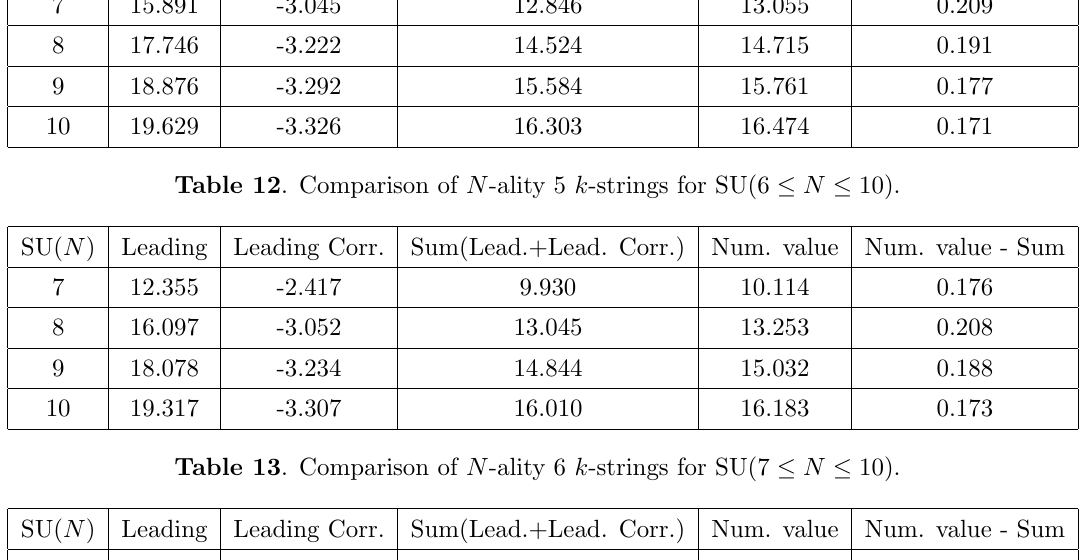
Table 13 . Comparison of N -ality 6 k -strings for SU(7